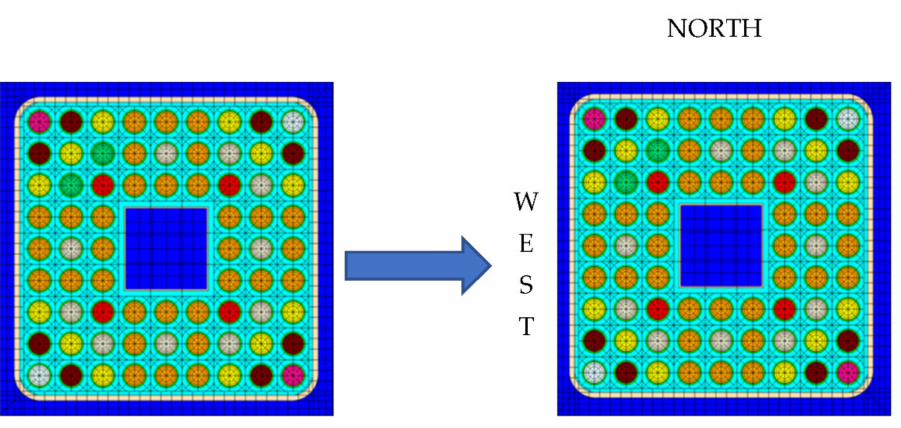
Figure 9. Modeling of channel bow for the BWR assembly.